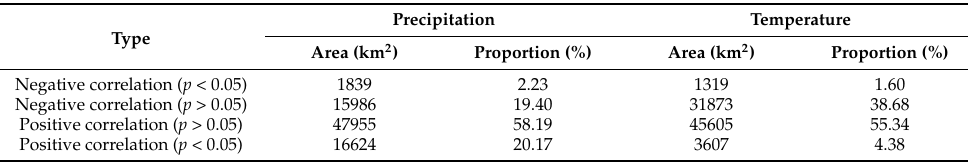
Table 3. Correlation of vegetation cover with climatic